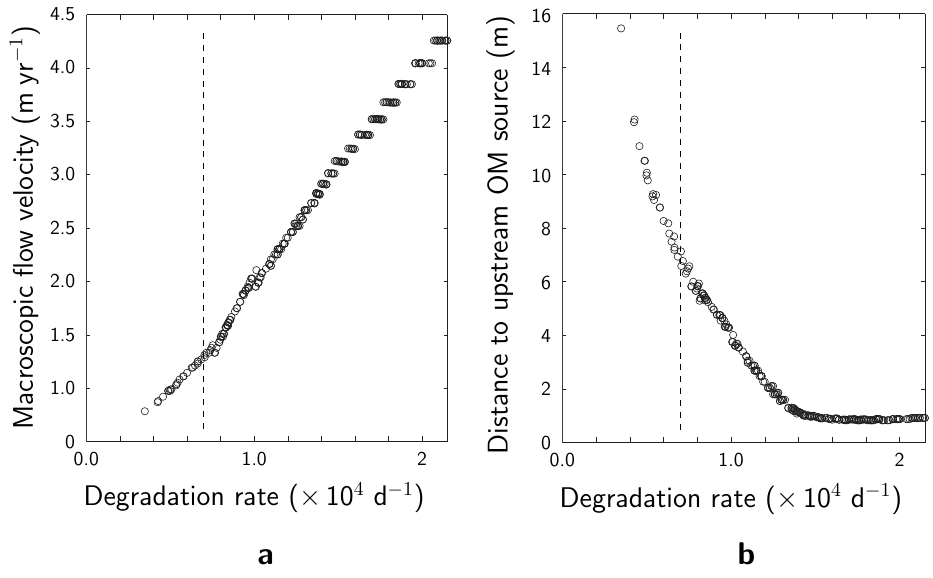
Fig. 9. Flow parameters of scenario B and their relation to the intermediate POC decay constant. (a) Macroscopic flow velocity required to cover the distance of 40m between core NN2 and NN1 in the length of time between the best fits of sulfate pore water profiles at respective locations. (b) Distance of core NN2 to the hypothetical source of OM. The dashed line marks the minimal relative RMSE at 0.7 × 10 − 4 d − 1 .